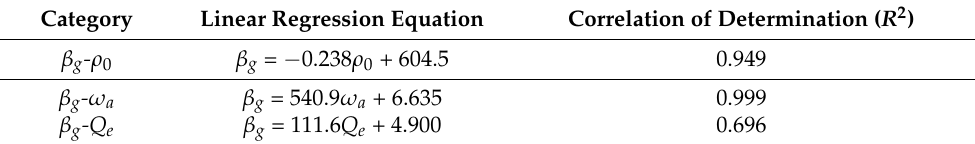
Table 4. Results of linear regression of the impact factor of the recycled aggregate and quality.